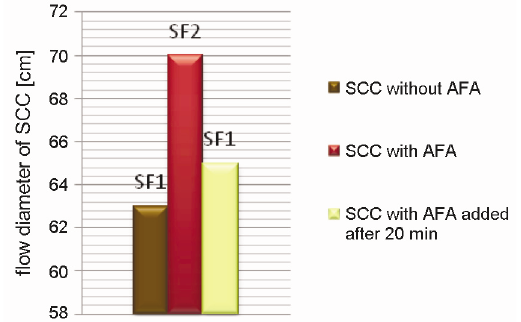
Fig. 10. The influence of AFA and the time of its introduction on flow diameter of SCC. Symbols SF 1 and SF2 represent slump-flow classes according to Table 1